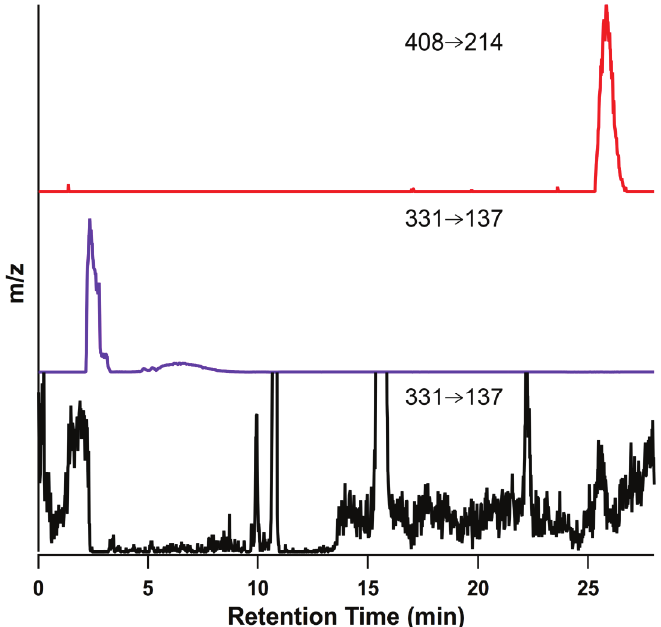
Figure 8. Reconstructed ion chromatogram of IS (top, red trace), authentic 2',3'-cIMP (purple trace), and extracted 2',3'-cIMP (bottom, black trace) from male rat brain using Xcalibur software. Transition 331 (cid:2) 137 m/z was monitored and reconstructed for extracted 2',3'-cIMP.